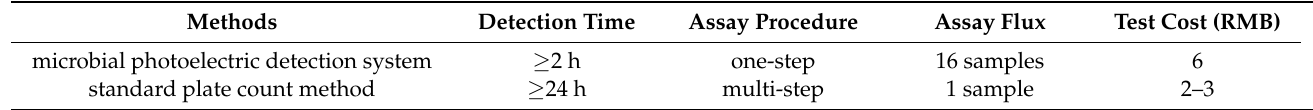
Table 2. Performance comparison between microbial photoelectric detection system and standard plate count